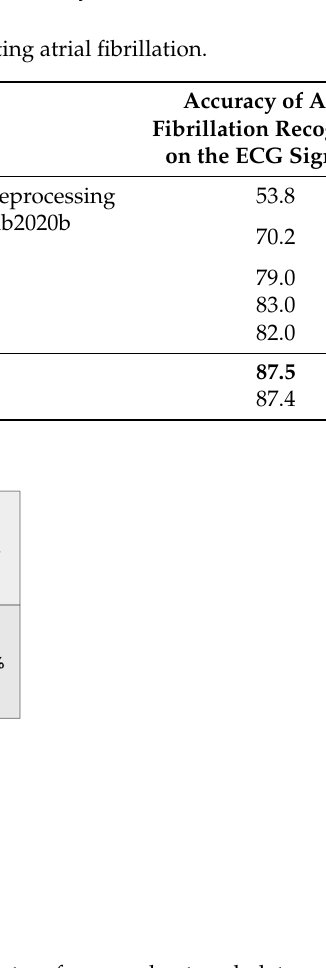
Figure 10. A confusion matrix is a result of training a system for neural network determination of atrial fibrillation on ECG signals with wavelet-based preprocessing.